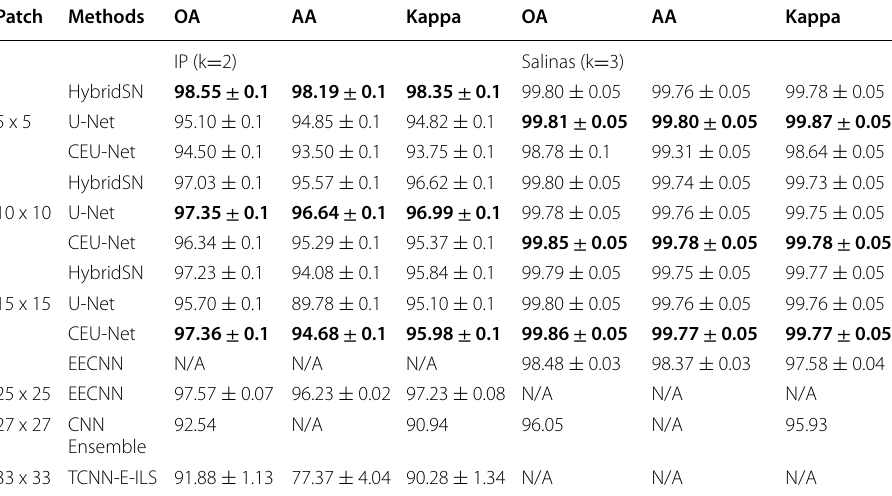
Table 6 Test metric results for each semantic segmentation method for the Indian Pines and Salinas datasets while employing patching for different patch sizes. For Deep CNN Ensemble T 10, for EECNN and TCNN-E-ILS T 20. An explanation of the metrics can be found in "Experiment = configurations"